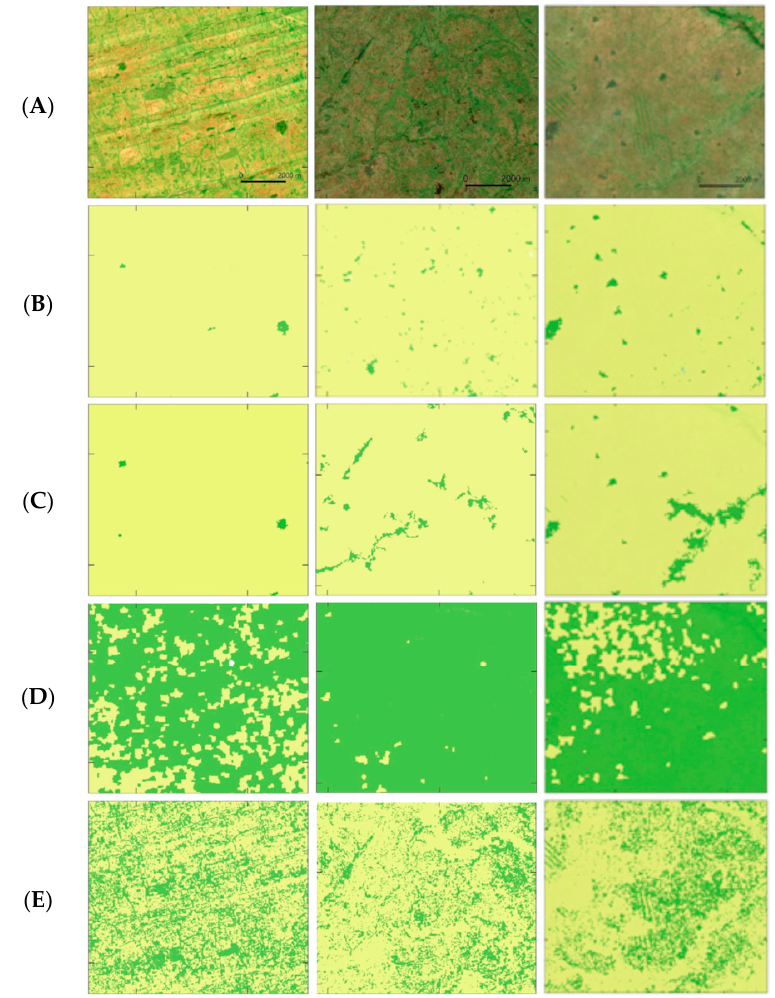
Figure 4. Examples of existing medium resolution remote sensing LCLU products providing information for northern Nigeria: ( A ) False color composition (754) of Landsat 8 image; ( B ) ESA land cover 20 m map of Africa; ( C ) GFSAD30AFCE; ( D ) Tsinghua University 30 m resolution LCLU map. Green: shrub; Light yellow: cropland; ( E ) Northern Nigeria 30 m resolution Landsat 8-based LCLU map. Green: natural vegetation; Light yellow: cropland.